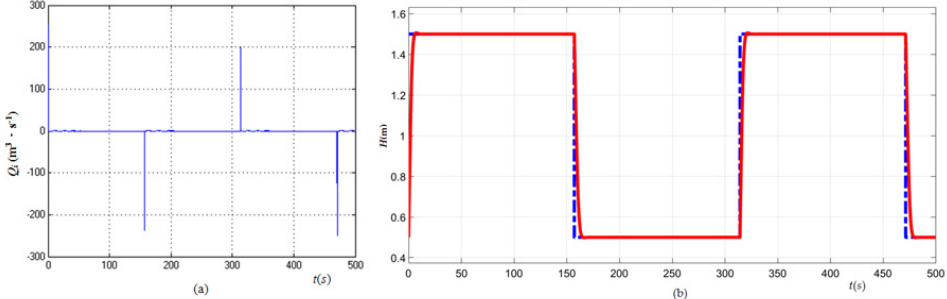
Figure 6. (a) and (b). Simulation results of linear feedback of the robust PID controller. The inflow